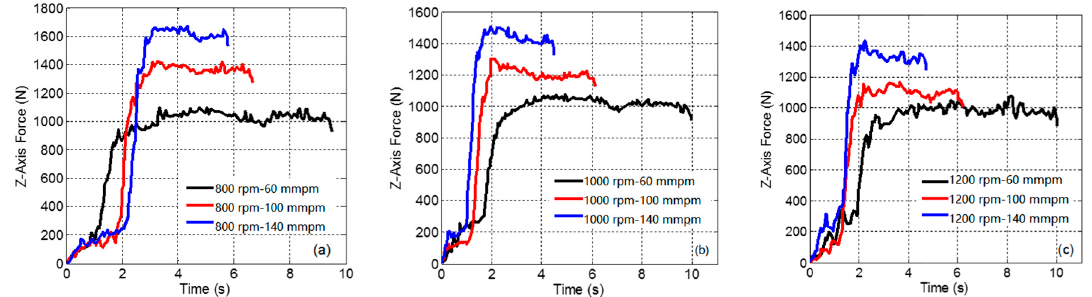
Figure 5. Axial force difference at different feed rates. ( a ) 800 rpm; ( b ) 1000 rpm; ( c ) 1200 rpm.